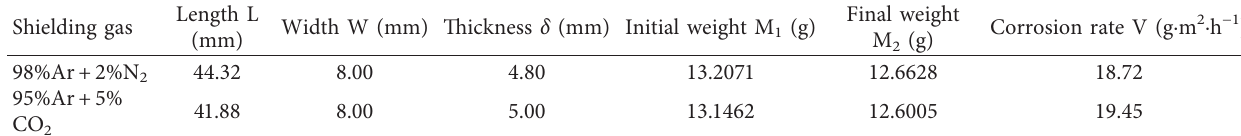
Table 4: Spot corrosion rate of welded joint.